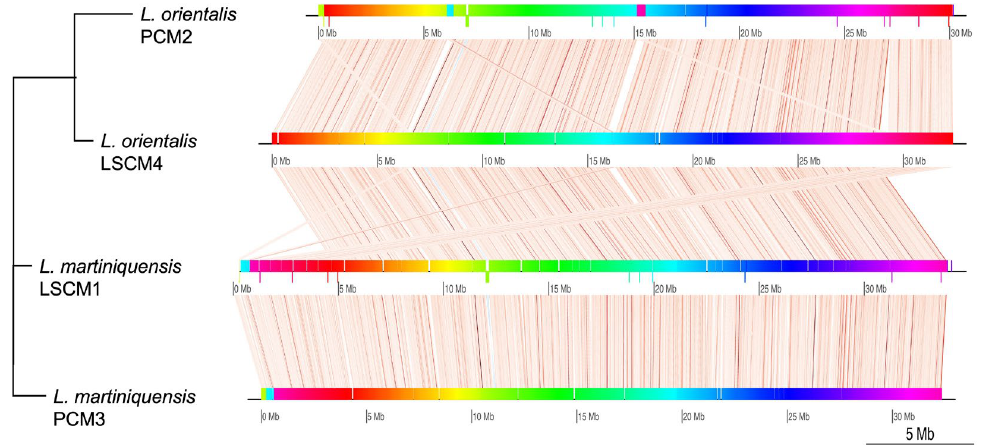
Figure 1. Alignment of genomic contigs from L. orientalis southern isolate PCM2 and L. martiniquensis southern isolate PCM3 compared to those of the northern isolates LSCM1 and LSCM4 in Thailand. Colored shades represented the conserved synteny, and the bar height indicates the level of sequence identity. Lines show associated conserved syntenic blocks across the compared isolates.